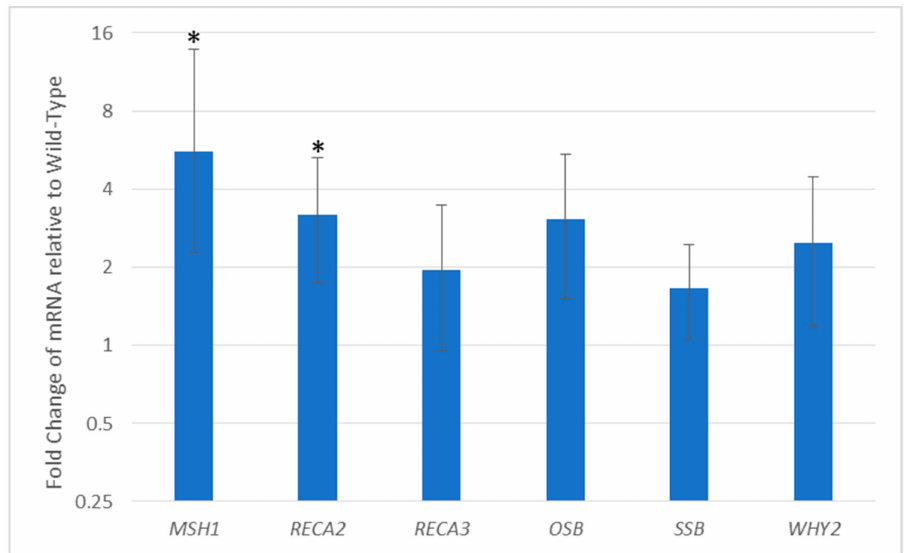
Figure 1. Quantitative RT-PCR assays of enzymes involved in double-strand break repair (DSBR) in UNG lines relative to wild-type: Fold change in transcript level is shown on the Y-axis. Error bars are standard deviation of three biological replicates. MSH1 and RECA2 are significantly transcriptionally upregulated in UNG lines relative to wild-type (5.60-fold increase and 3.19-fold increase, respectively. Unpaired, 2-tailed student’s t-test, * indicates p < 0.05). OSB1 is nearly significantly upregulated in UNG lines relative to wild-type (3.07-fold increase. Unpaired t-test p =